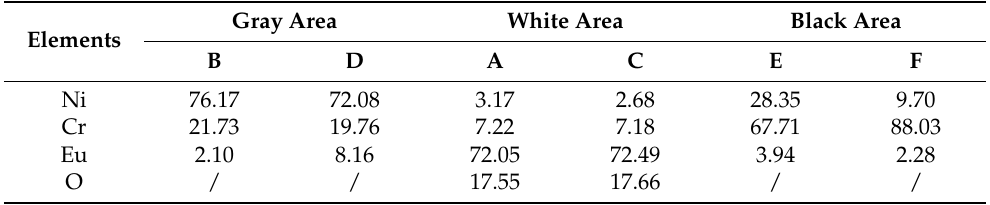
Table 2. Chemical composition (wt.%) at each point in HP15